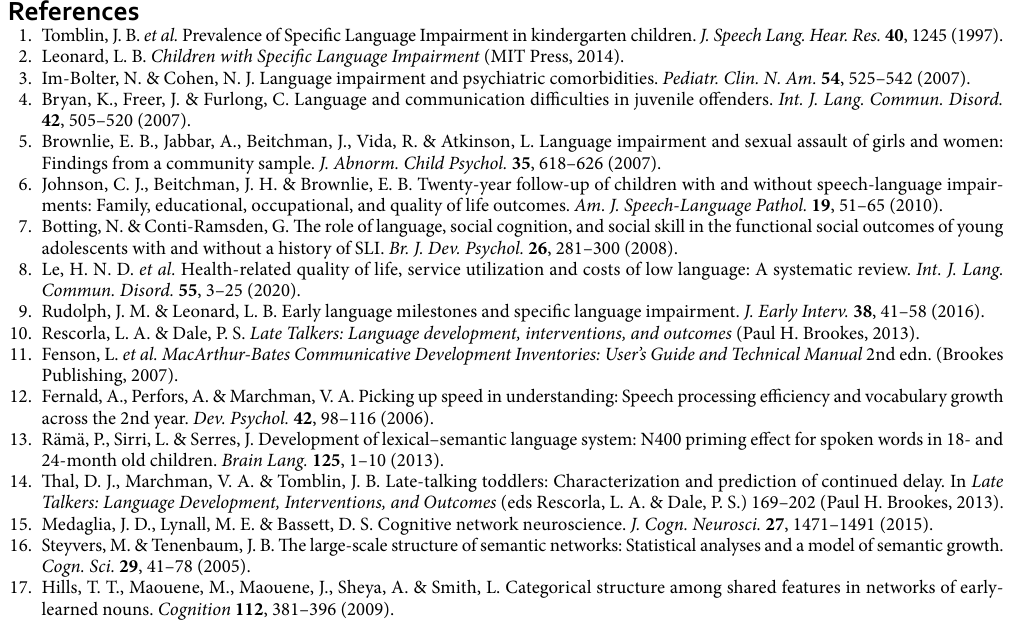
Data availability